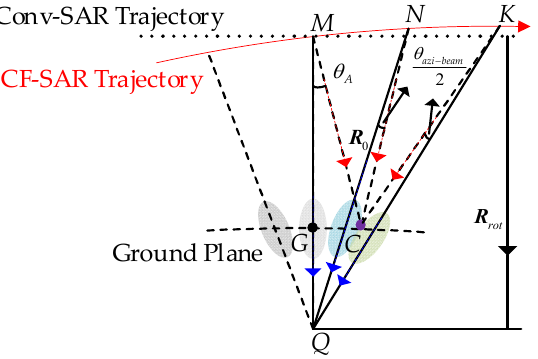
where ∠ MQN and ∠ MQK denote the rotation angle of CLF-SAR relative to Q at N and K , respectively, and ∠ MCN and ∠ MCK denotes the rotation angle of CF-SAR relative to C at N and K , respectively.